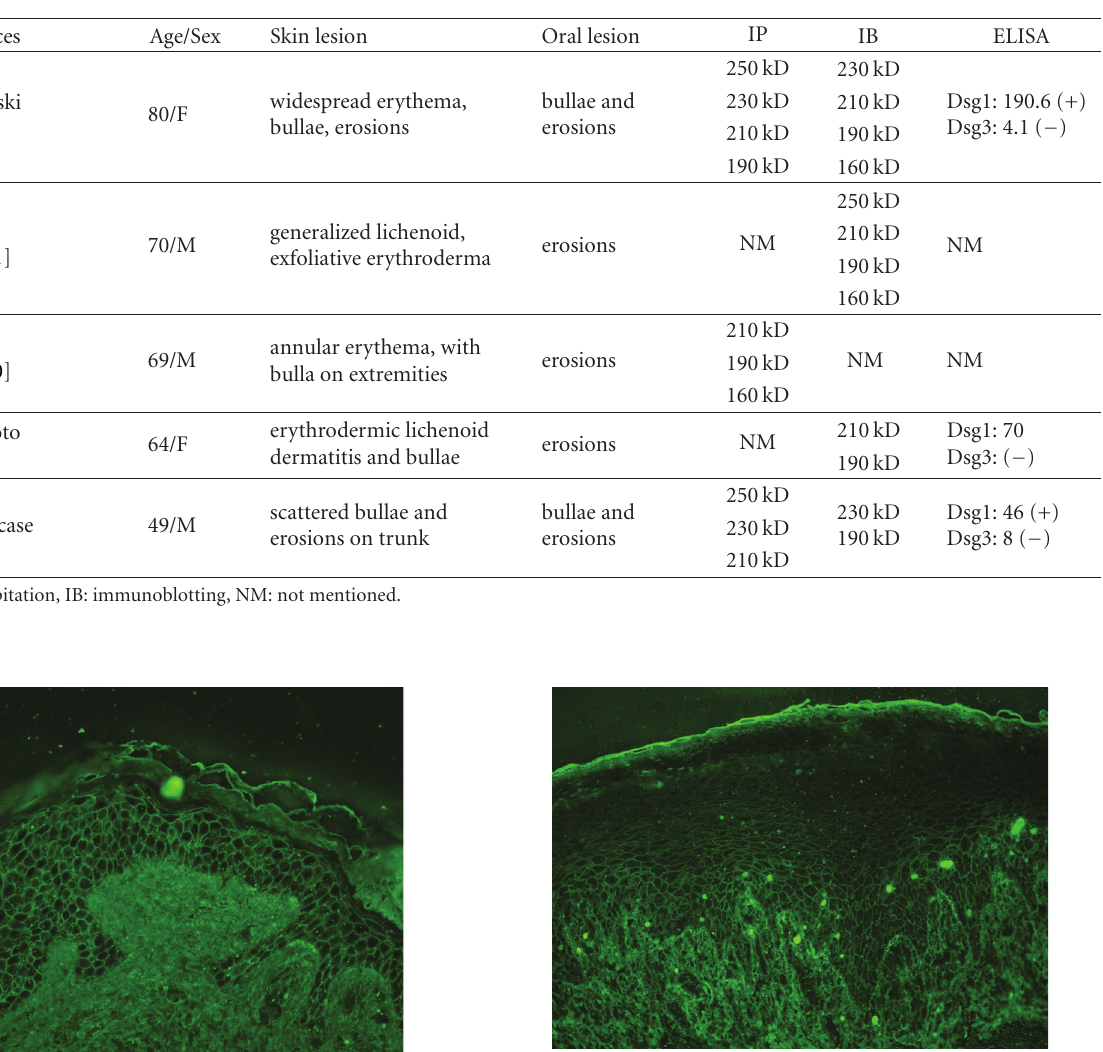
Figure 6: Direct immunofluorescence of the oral mucosa. Cell surface deposits of IgG in the lower layer of epithelium with ovoid bodies.